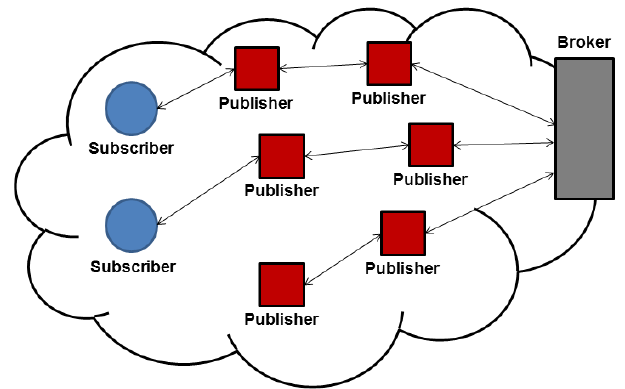
Figure 19. General View of Multi-Hop Extended